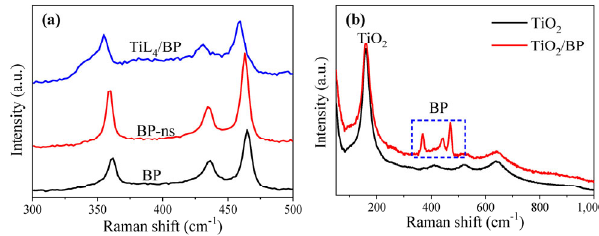
Fig. 2 Raman spectra of the nanocomposites: (a) TiL 4 /BP and (b) TiO 2 /BP.